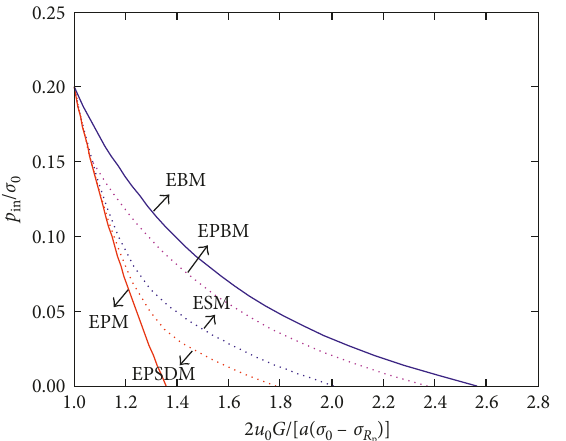
Figure 7: The influence of support resistance on the surface displacement. Table 4: The post-peak failure radii and surface displacement when p in (cid:31)